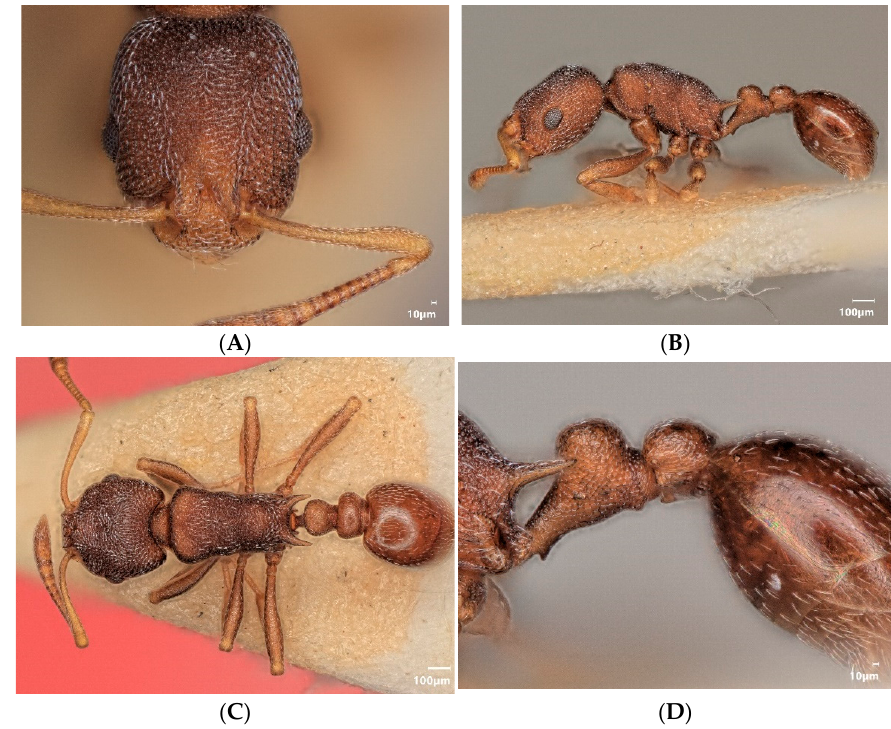
Figures 11. Cardiocondyla semiargentea n.sp.: paratype, head in dorsal view ( A ) , lateral view ( B ), dorsal view ( C ) waist in frontolateral view ( D ).